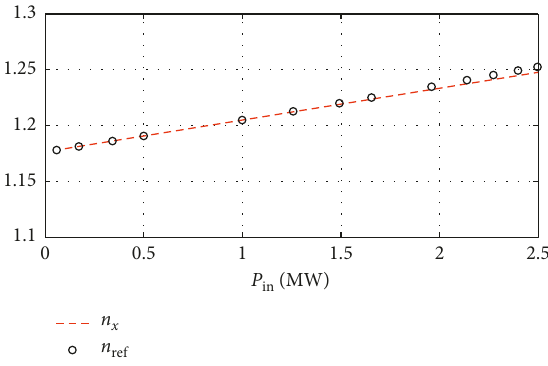
for a silica rod as eff eff